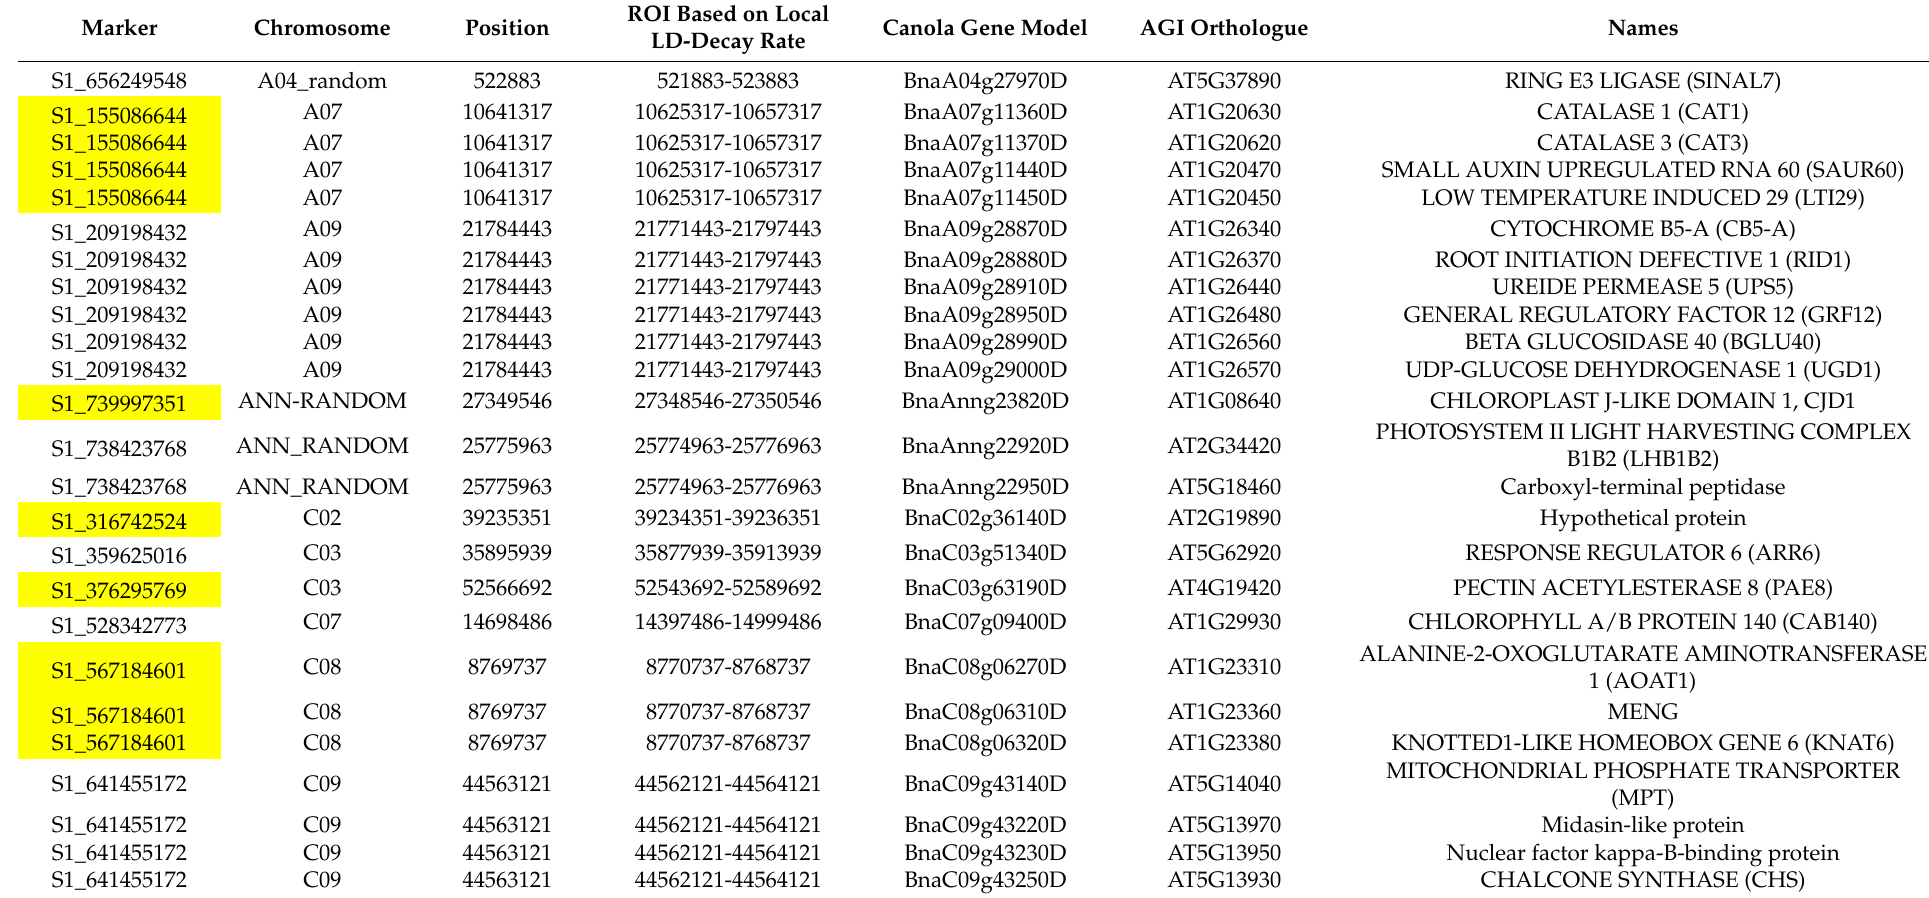
Table 4. Candidate genes involved in cold acclimation and freezing